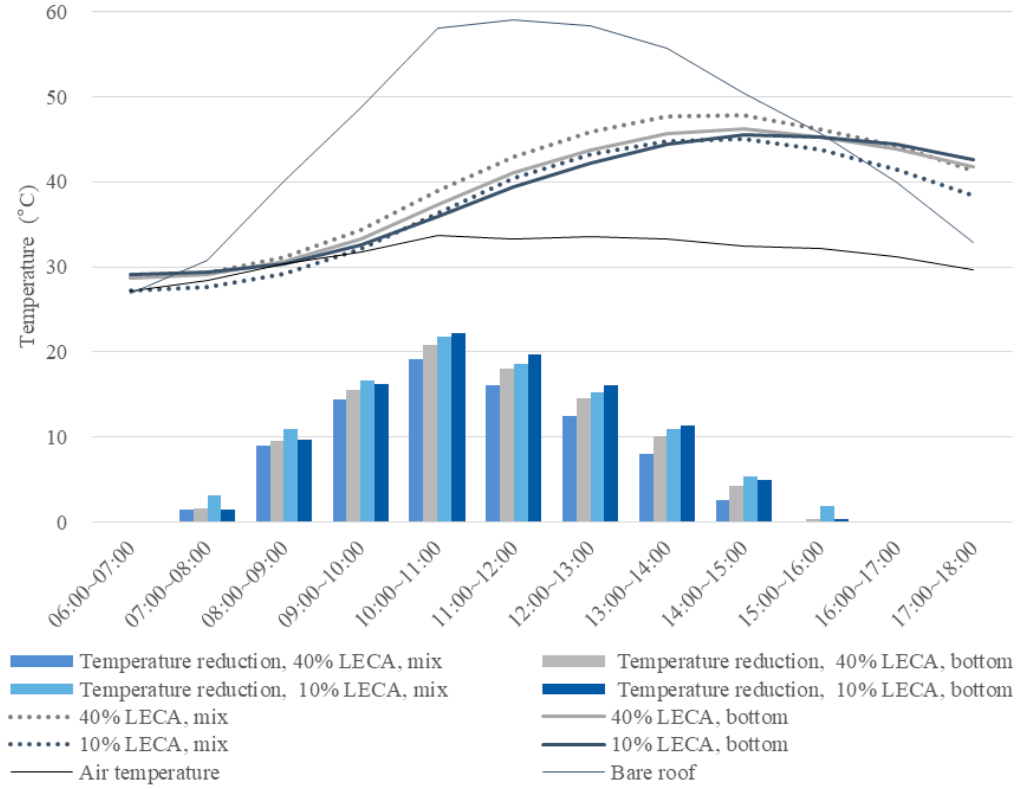
Figure 14. Temperatures and temperature reductions in the cases of the roofs with 10% and 40% LECA laid at the bottom without plants, and of 10% and 40% LECA mixed with the soil without plants (24 September 2017 06:08:41 to 24 September 2017 17:58:41).